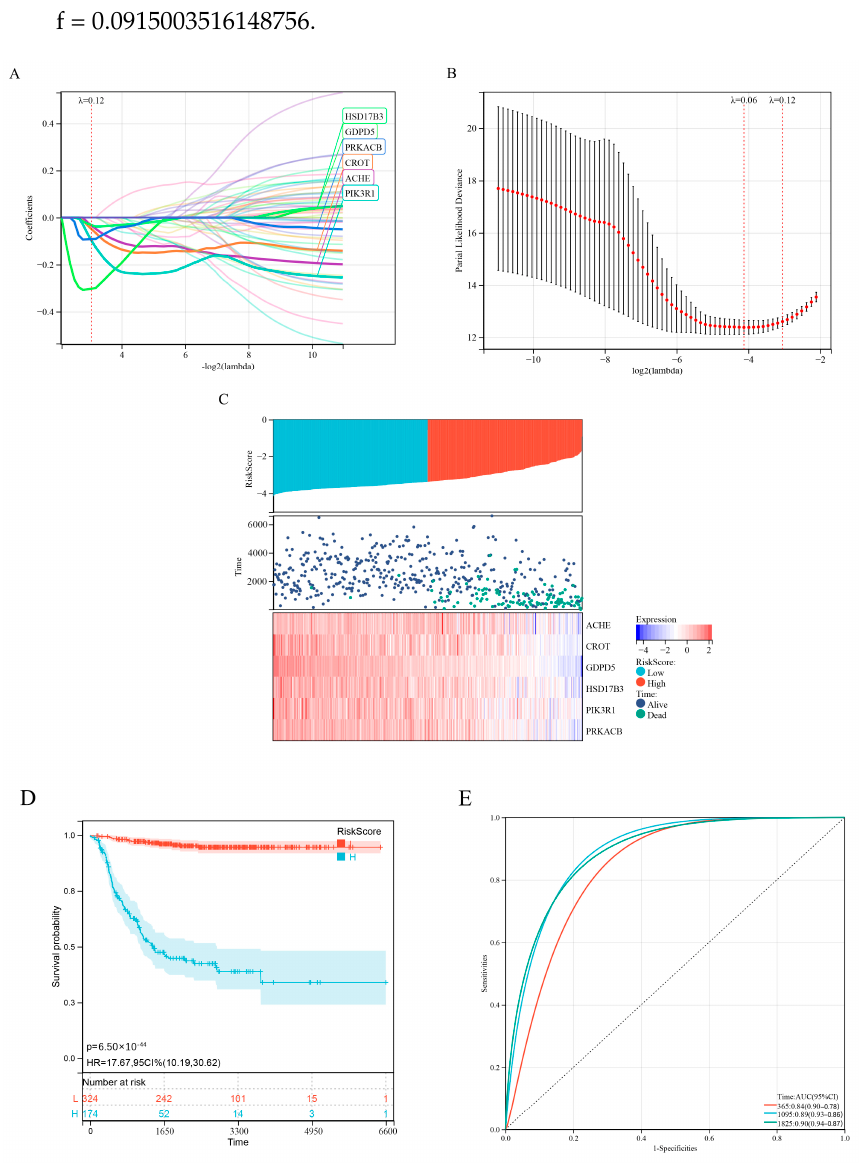
Figure 2. Development of a prognostic model for lipid metabolism genes. ( A ) Lasso coefficient pro- files of 58 prognosis − related lipid metabolism genes from the Discovery (GSE49710 microarray) da- taset. ( B ) Partial likelihood bias of the variable revealed by the Lasso regression model. The red dots represent the partial likelihood of deviated values, the grey line represents the standard error (SE) and the left and right vertical dashed lines represent the minimum standard and the best value for the 1 − SE standard, respectively. ( C ) Expression heatmap of six signature genes, risk score distribu- tion and survival status of patients. ( D ) Kaplan − Meier analysis of 6 − gene risk scores. ( E ) ROC curve analysis of 6 − gene risk score. 2.3. Further Refinement of the Prognostic Model To further optimize the prognostic model, we performed multivariate Cox analysis on the six genes (ACHE, CROT, GDPD5, HSD17B3, PIK3R1, PRKACB) in the risk score formula. The results showed that ACHE, GDPD5 and PIK3R1 were independent prognos- tic factors (Figure 3A). We then constructed a new risk score using these three genes: Risk Score = ACHE*0.862854240578636 + GDPD5*0.777001638391889 + PIK3R1*0.646763659363925.